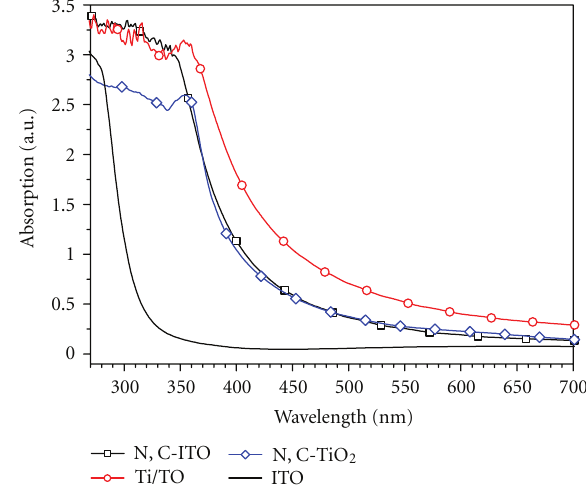
Figure 4: Absorption spectra of the composite Ti/TO electrode along with N,C-TiO 2 , N,C-ITO and ITO film electrodes.